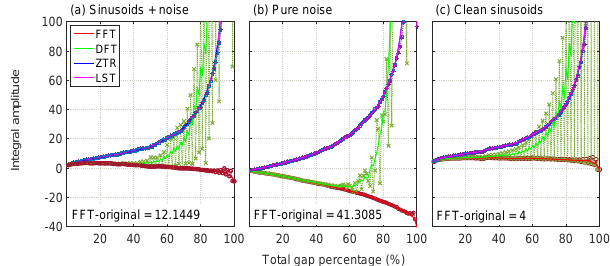
Figure 6. SLG test applied to the synthetic data: integral ampli- tudes as a function of TGP for the signal with noise (panel a ), for pure noise (panel b ) and for the clean signal (panel c ). The clean signal is obtained by removing the noise from the original signal (see Fig. 1). Colors denote the four methods. The thick lines are the average